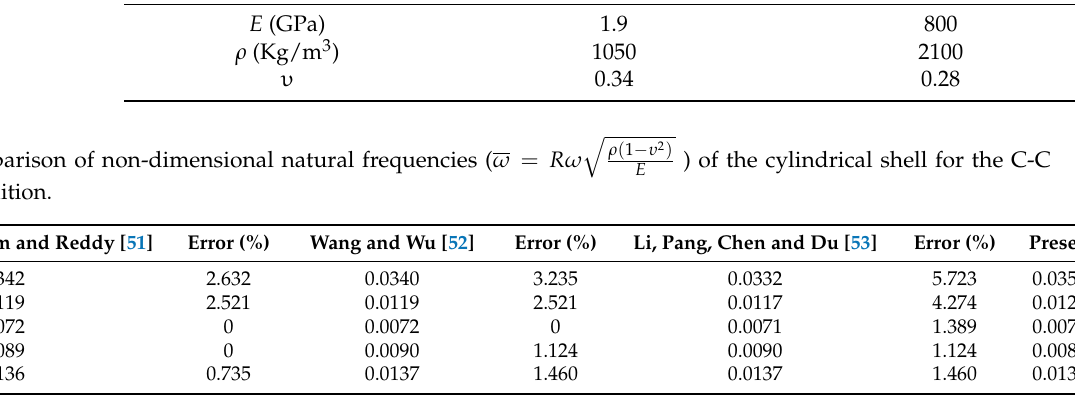
Table 1. The properties of the constituent materials of the MWCNT-reinforced nanocomposite shells.